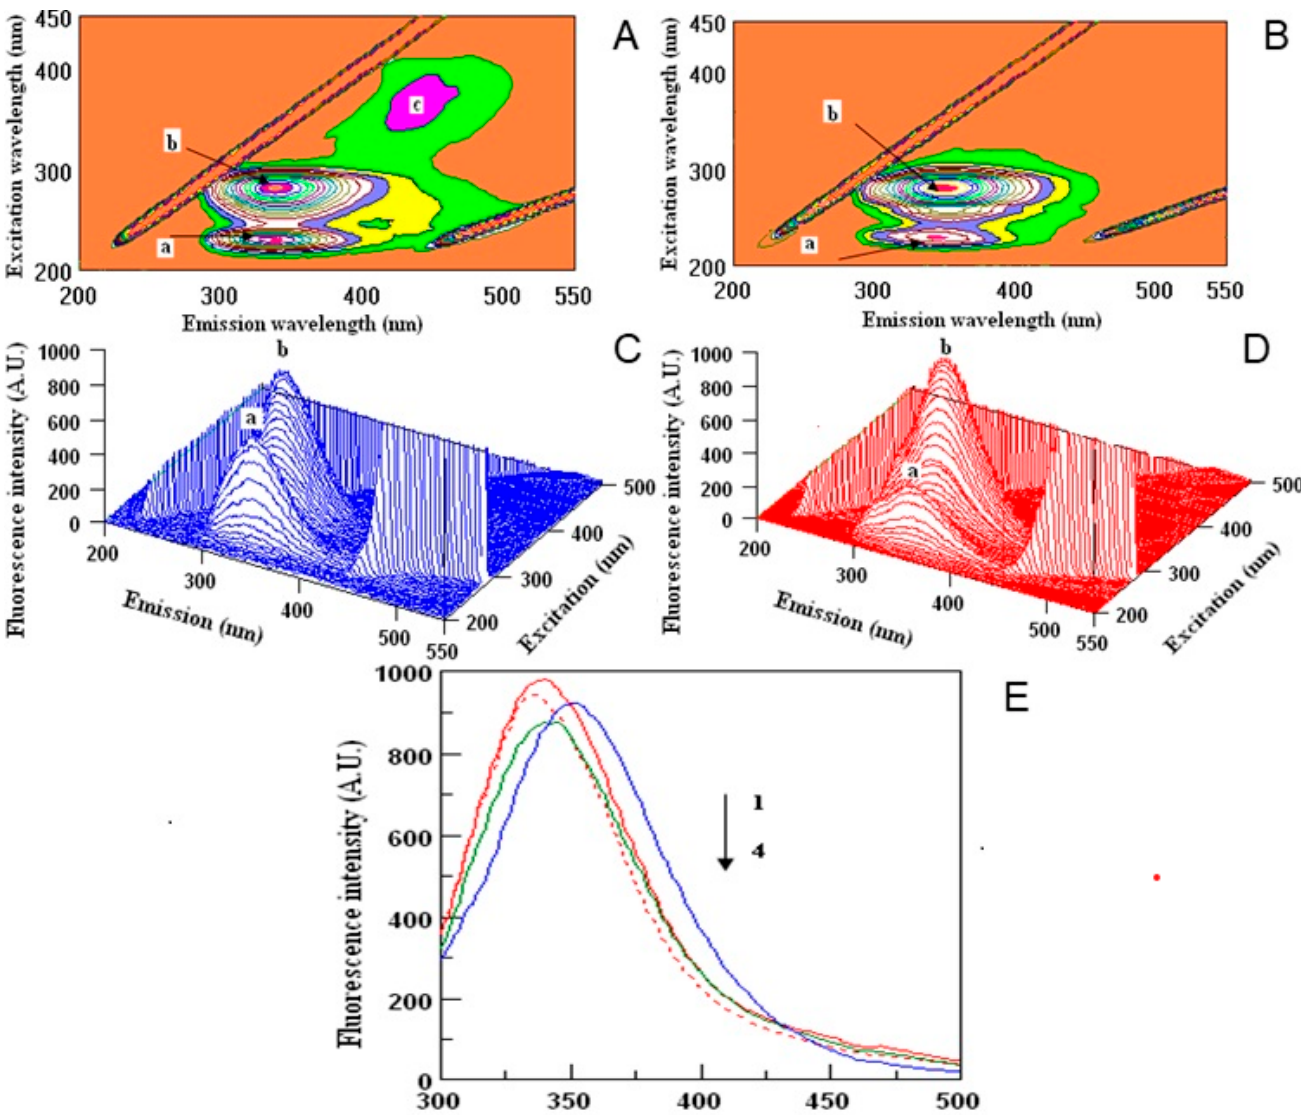
Figure 3. Counter maps ( A , B ) and their three-dimensional fluorescence (3D-FL) spectra ( C , D ) of interaction of human serum albumin (HSA) with polyphenols water extracts of Thai ( A , C ) and Israeli ( B , D ) dragon fruits; two-dimensional (2D-FL) fluorescence intensities (FI) from the top ( E ): 1, HSA in buffer; 2, HSA + water; 3, HSA + water extract of Thai; and 4, HSA + water extract of Israeli dragon fruits with λ em (nm) of 340, 336, 352 and 340; FI of 983.18; 945.87; 927.13 and 876.65 arbitral units.